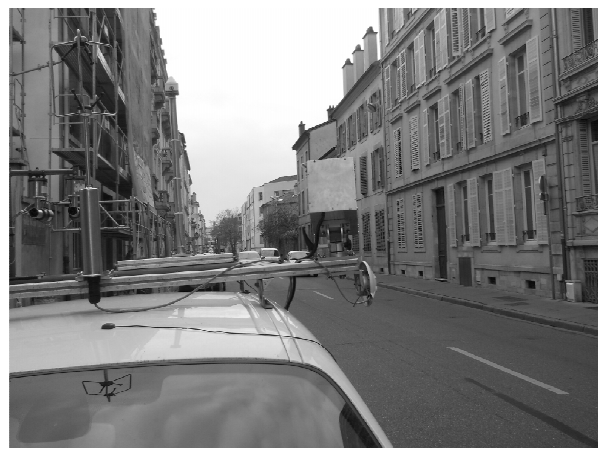
Figure 5. Configuration of the street in Nancy (France) for the val- idation of the two different approaches to traffic implementation in TEB.